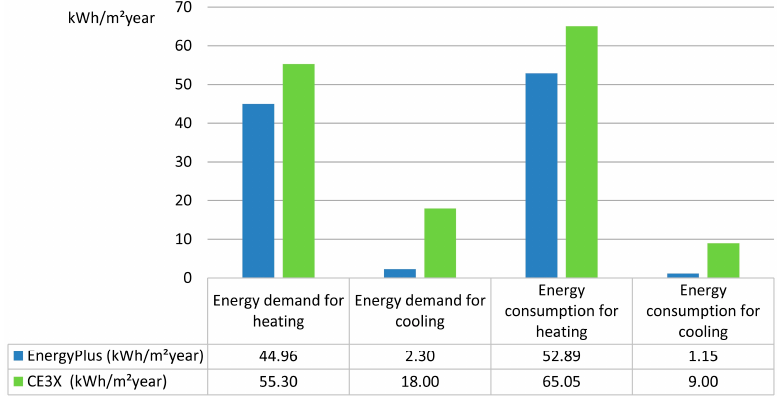
Figure 7. Overview of the building’s efficiency according to EnergyPlus (Design Builder) and CE3X.